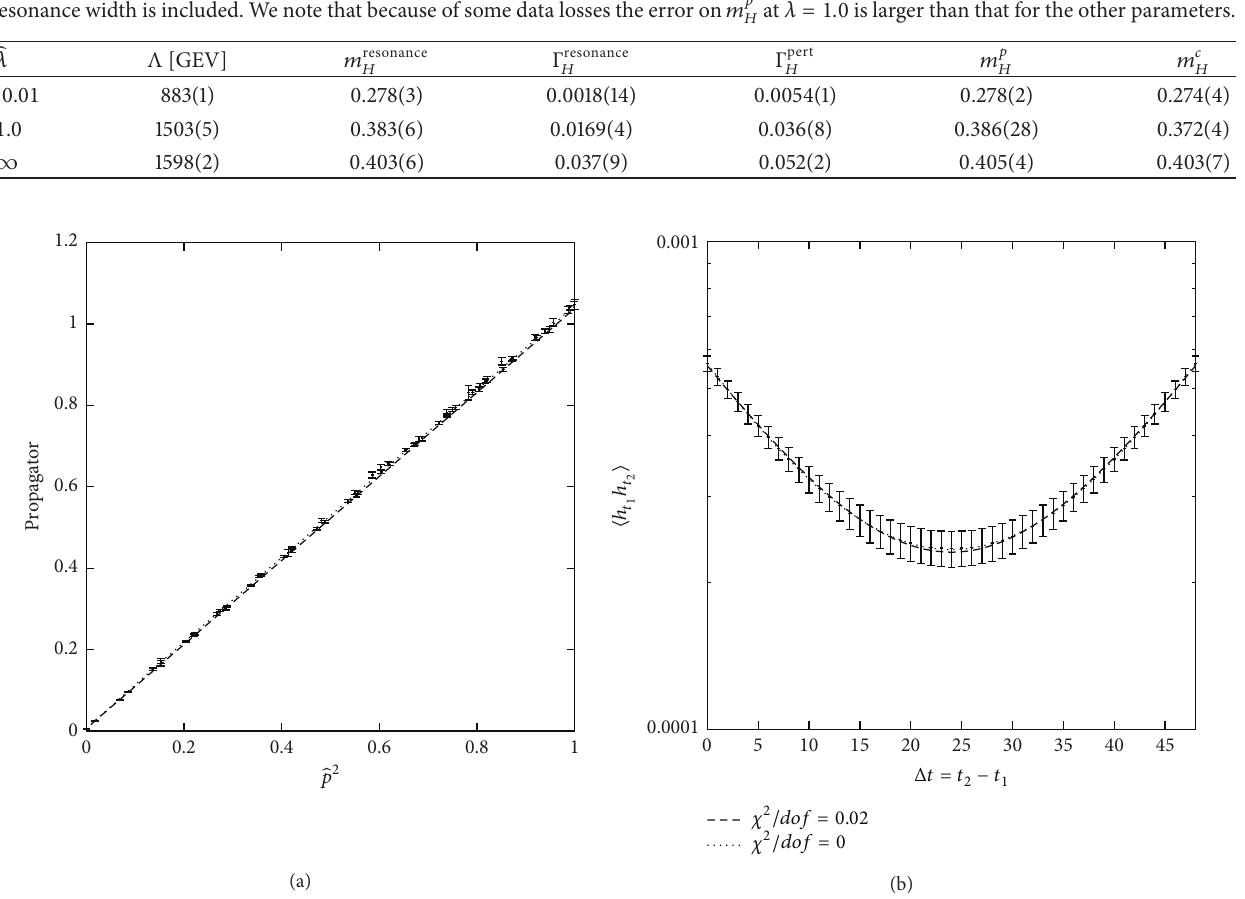
Figure 2: Examples of fits to the Higgs momentum space propagator and the Higgs temporal correlation function to obtain 𝑚 𝑝 𝐻 and 𝑚 𝑐 𝐻 , respectively. The results are from a 24 3 × 48 lattice with 𝑚 𝑓 = 195 GeV, Λ = 1.5 TeV. The fitted values are 𝑚 𝑝 𝐻 = 96.0 (4.3) GeV and = 96.4 (6.9) GeV where the errors are statistical only and do not reflect the uncertainty in the scale determination which, however, affects 𝑚 𝑐 𝐻 both values in the same